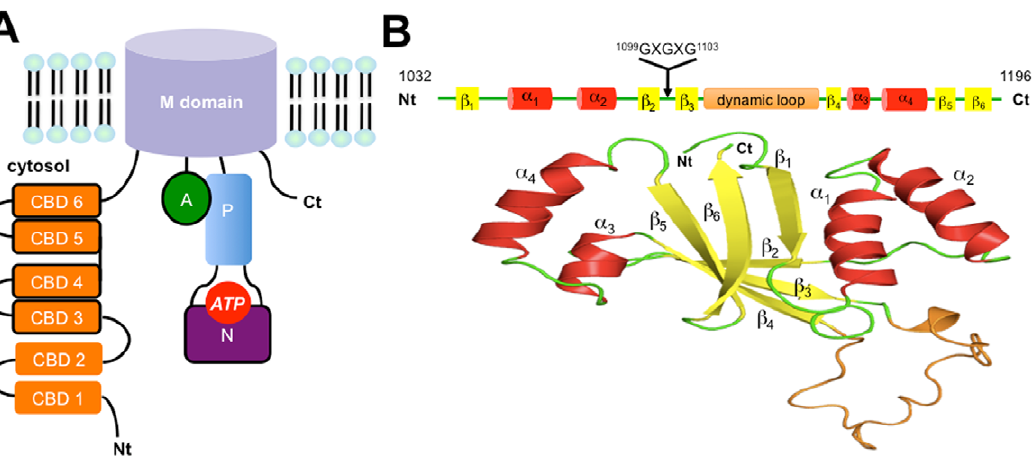
Figure 1. General organization of the ATP7B protein. (A) The different domains of the protein are presented: the six Copper Binding Domains (CBD), the transmembrane domain (domain M), the Actuator domain (A), the Phosphorylation domain (P) and the Nucleotide-binding domain (N). The different domains, which have been structurally characterized, are framed in black. (B) Sequence and structure available for the N-domain. Secondary structures and the dynamic loop are shown along with the position of the poly-glycine loop (GXGXG).